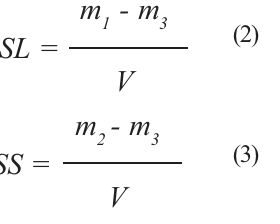
TABLE 2- Results of degree of conversion (DC%), solubility and salivary sorption